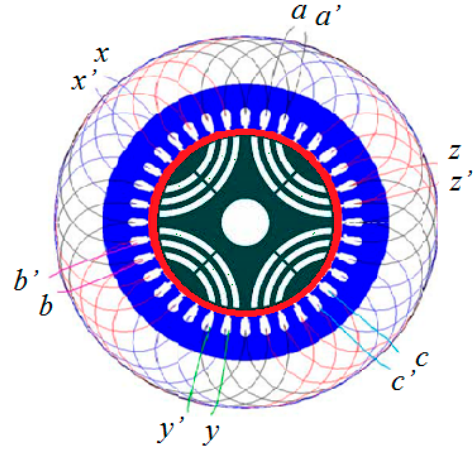
Figure 1. Abridged general view of the six-phase synchronous motor.